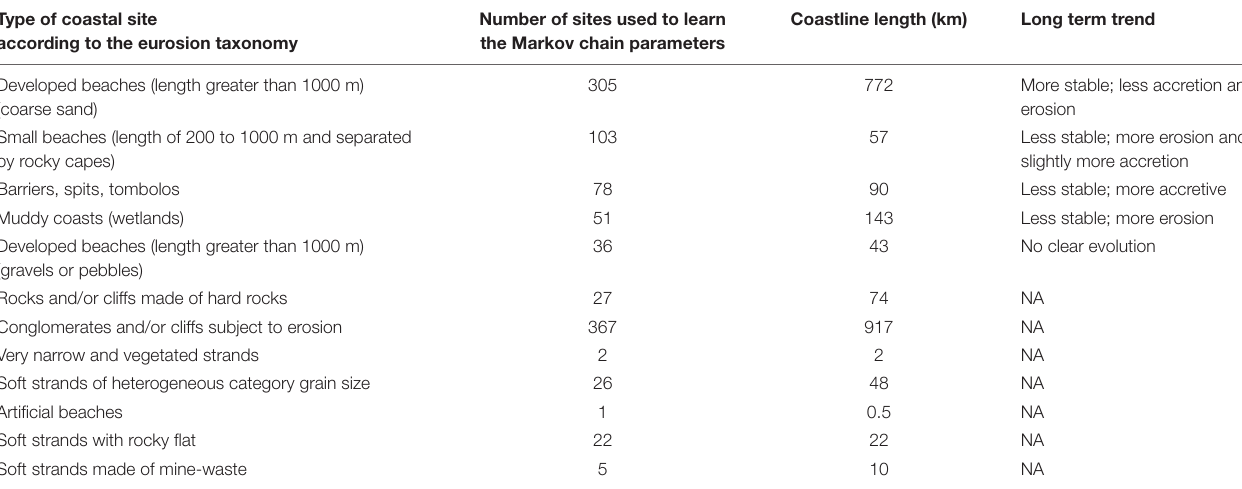
FIGURE 6 | Location, number of coastal sites and coastline length for coasts inventoried in the European coastal databases meeting the following criteria: (A) all coastlines of the Eurosion database, including coastlines without any information; (B) as in panel A , limited to segments where observations are included in the 1980s, in the 1990s or both; (C) as in panel B , with observations in the 1980’s updated in the 1990’s (note that this does not imply that all fields are described for all these coastal sites); (D) as in panel C , with information on coastal geomorphology and evolution in both the 1980’s and 1990’s; (E) : as in panel D , limited to coastal sites exposed to a sea-level rise close to the global average, to energetic offshore waves conditions and to a macrotidal regime (see section “Methods”); (F) as in panel E , without coastal defenses. TABLE 2 | Summary of results of the analysis of the temporal dynamics using Markov chain, for sites without coastal defense